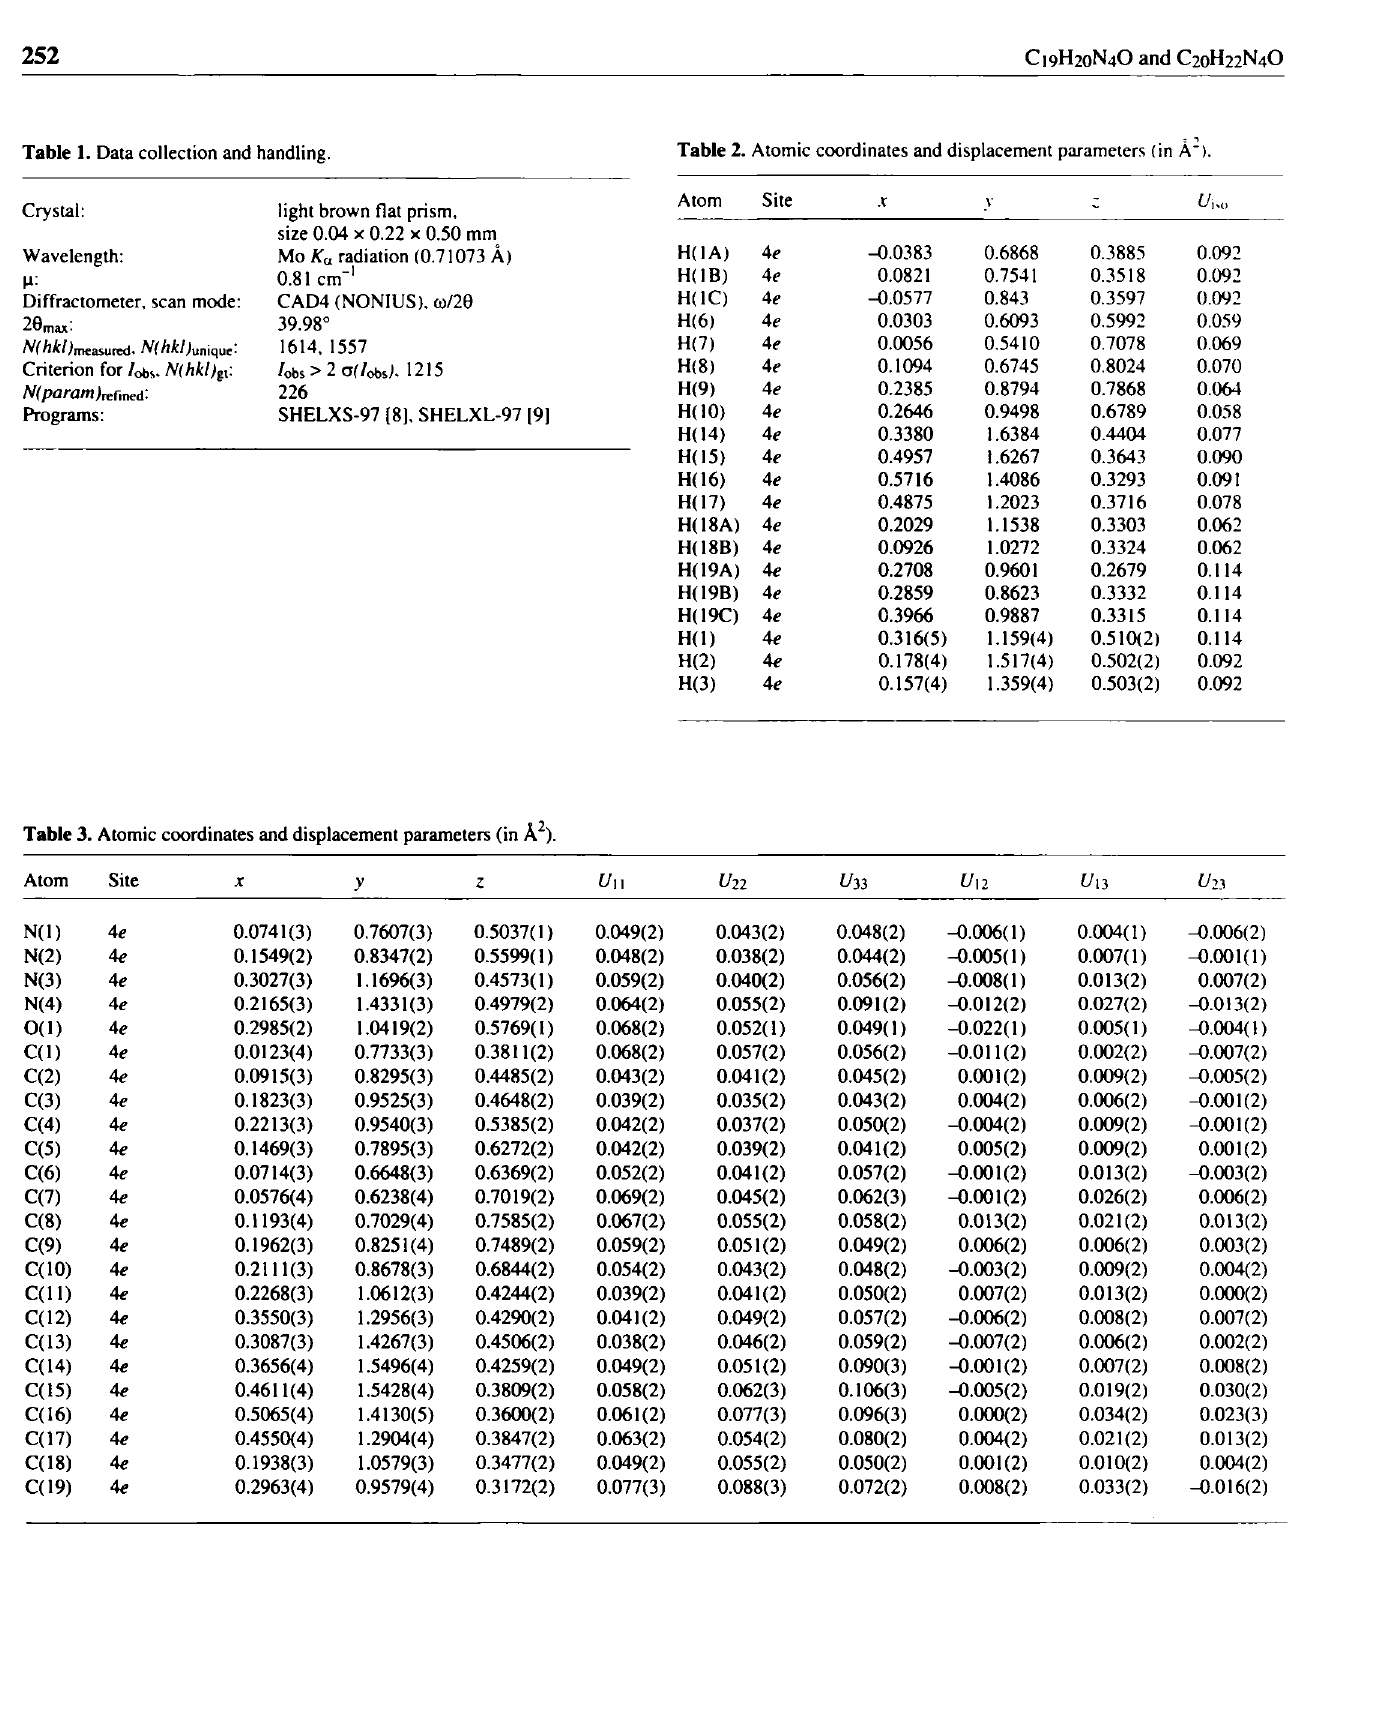
Table 1. Data collection and handling. Table 2. Atomic coordinates and displacement parameters (in Ä").